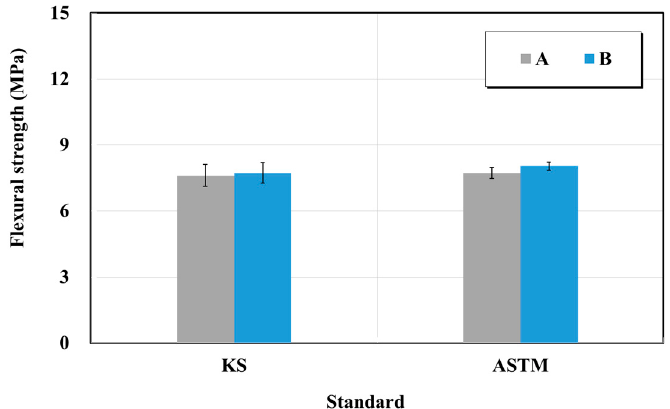
Figure 8. Flexural strength test results of structure restoration materials (repair mortar) obtained based on the KS and ASTM standards.